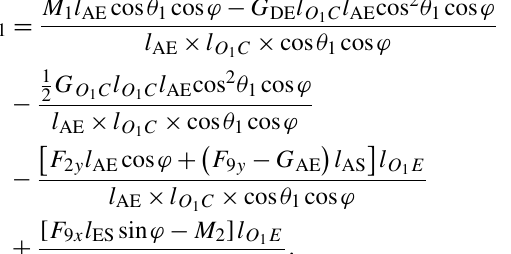
Figure 7. The process of crossing the obstacle (vibration damper).